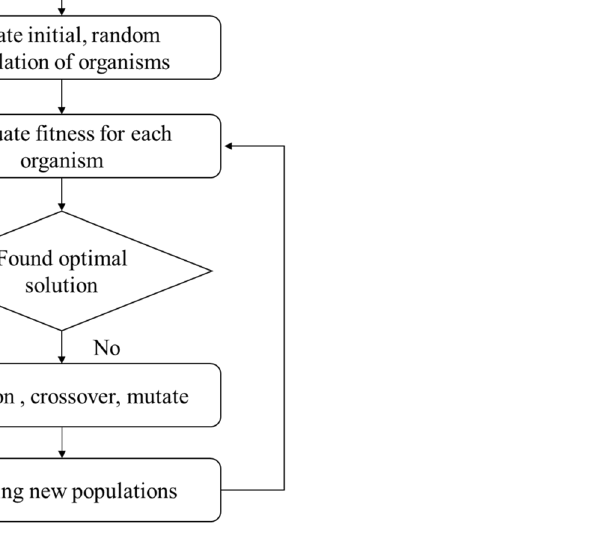
Figure 1. Flow chart of Genetic